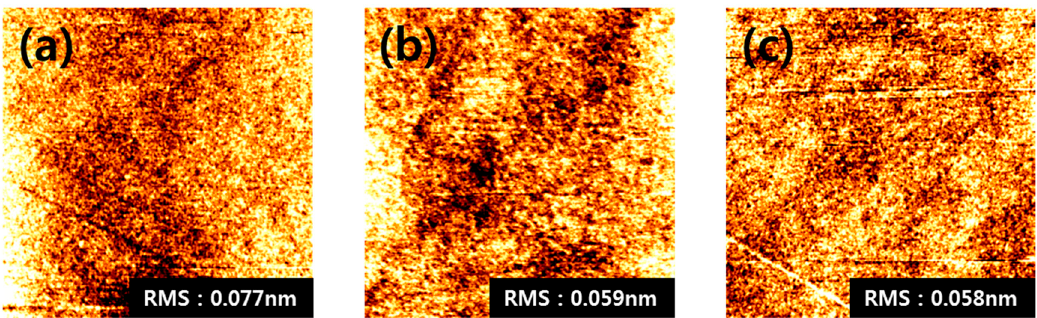
Figure 3. Atomic force microscopy (AFM) images (5 × 5 μ m) of RPALD SiN x film deposited at ( a ) ◦ C, and ( c ) 500 ◦ C. 250 °C, ( b ) 350 °C, and ( c ) 500 °C. ( b ) 350